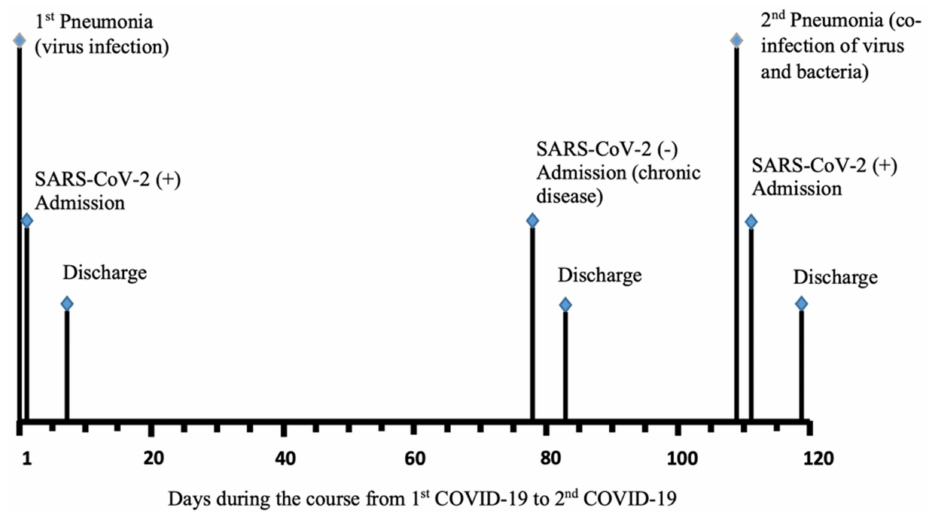
Figure 3. Example of a timeline of reinfected patients’ testing